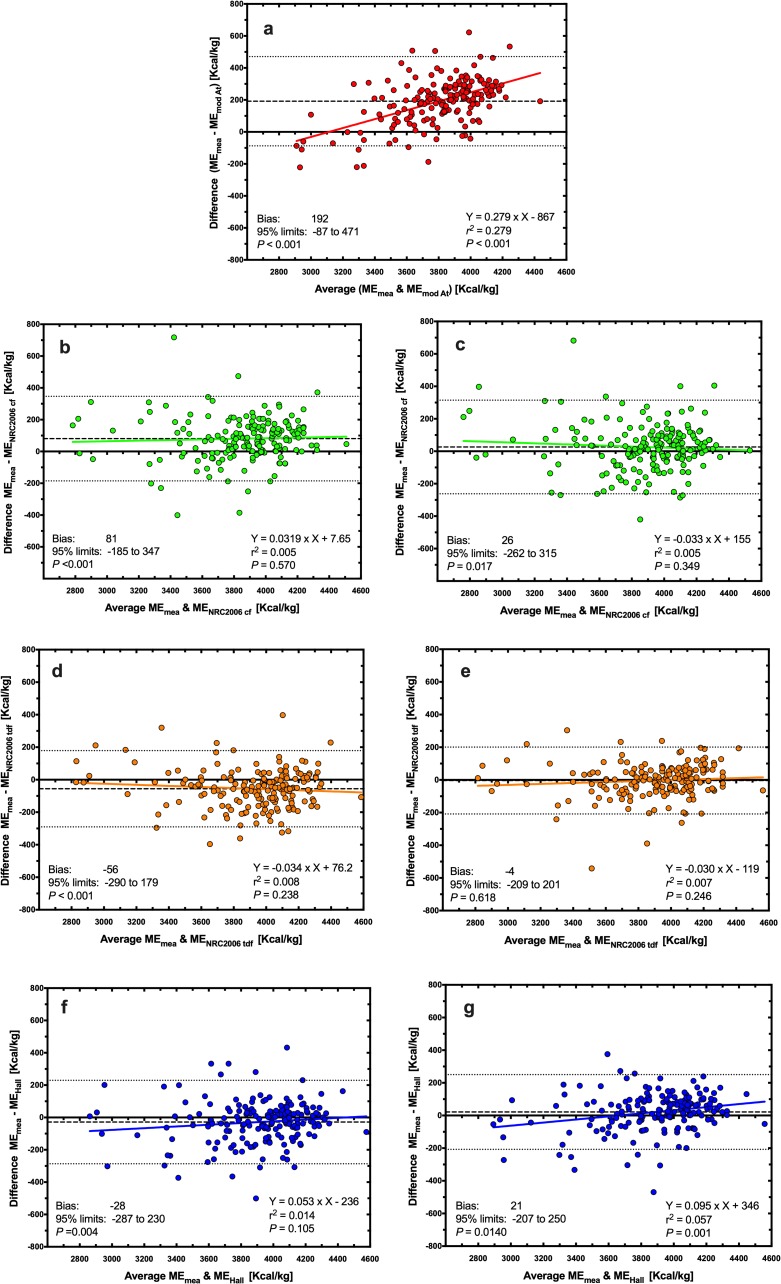
Bland-Altman plot depicting the relationship between measured and predicted metabolisable energy (ME) content in dry canine diets.The y- and x-axes depict the difference between and the average of the measured and predicted ME content of dry canine diets, respectively. The points represent results for individual foods, the dashed back line depicts the average bias, the dotted black lines depict the 95% confidence limits to the agreement, and the solid coloured line MA Atwater (red, a), NRC 2006cf (green; b: predicted GE, c: measured GE), NRC 2006tdf (orange; d: predicted GE; e: measured GE), and Hall equations (blue; f: predicted GE; g: measured GE).